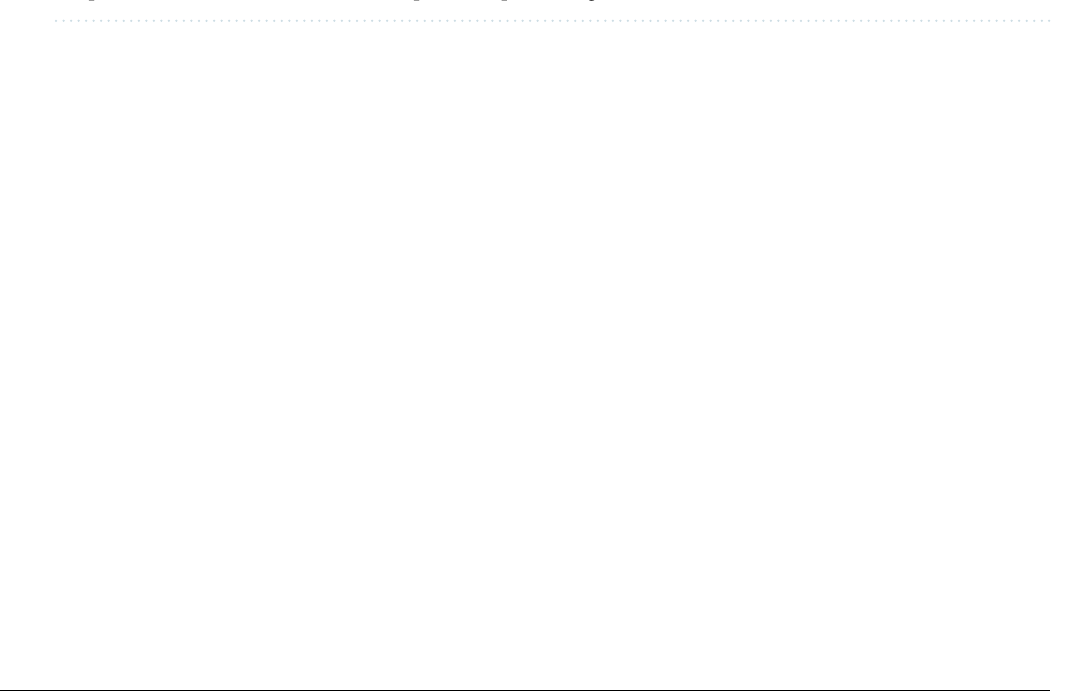
Figure 12. ( a ) Ln TOF versus 1/T plot in course of FA dehydrogenation by Ag 1 Pd 1 /SLCN at diverse temperatures, ( b ) Initial TOF versus temperatures plot for Ag 1 Pd 1